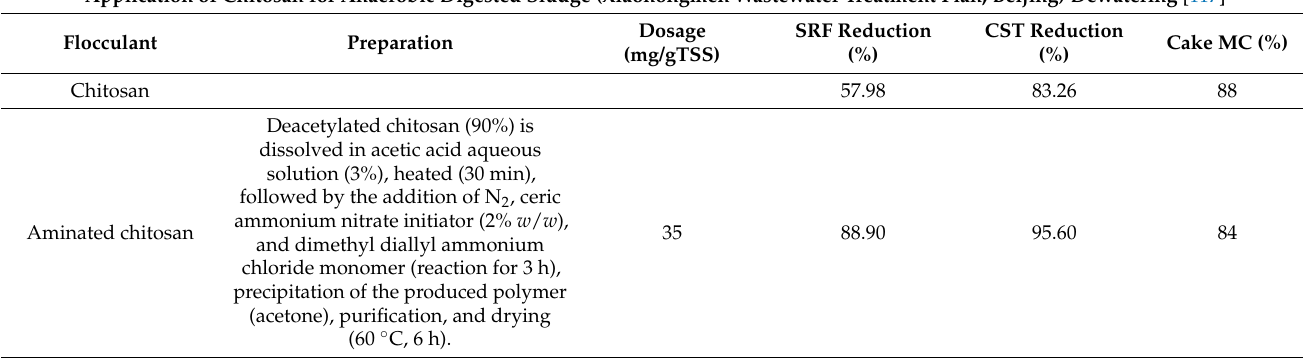
Table 3. Applications of animal-based flocculants for sludge